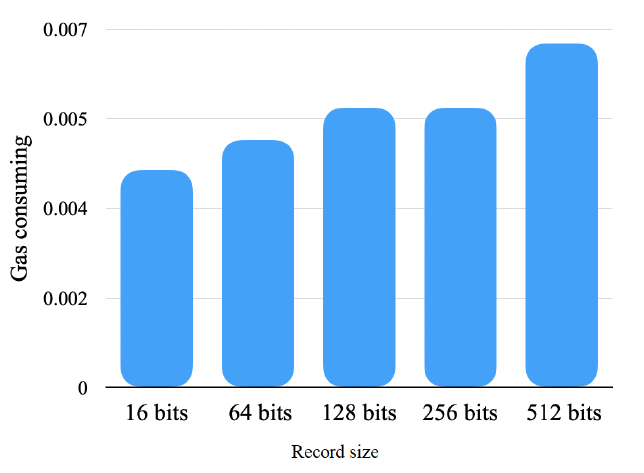
Figure 7. Encryption algorithms’ consuming gas in eth with different records sizes. We vary the record size (16 bits, 64 bits, 128 bits, 256 bits, and 512 bits) and measure the consumed gas for uploading the record to the blockchain. For each record size, we conduct the experiment 5 times and next take the average.